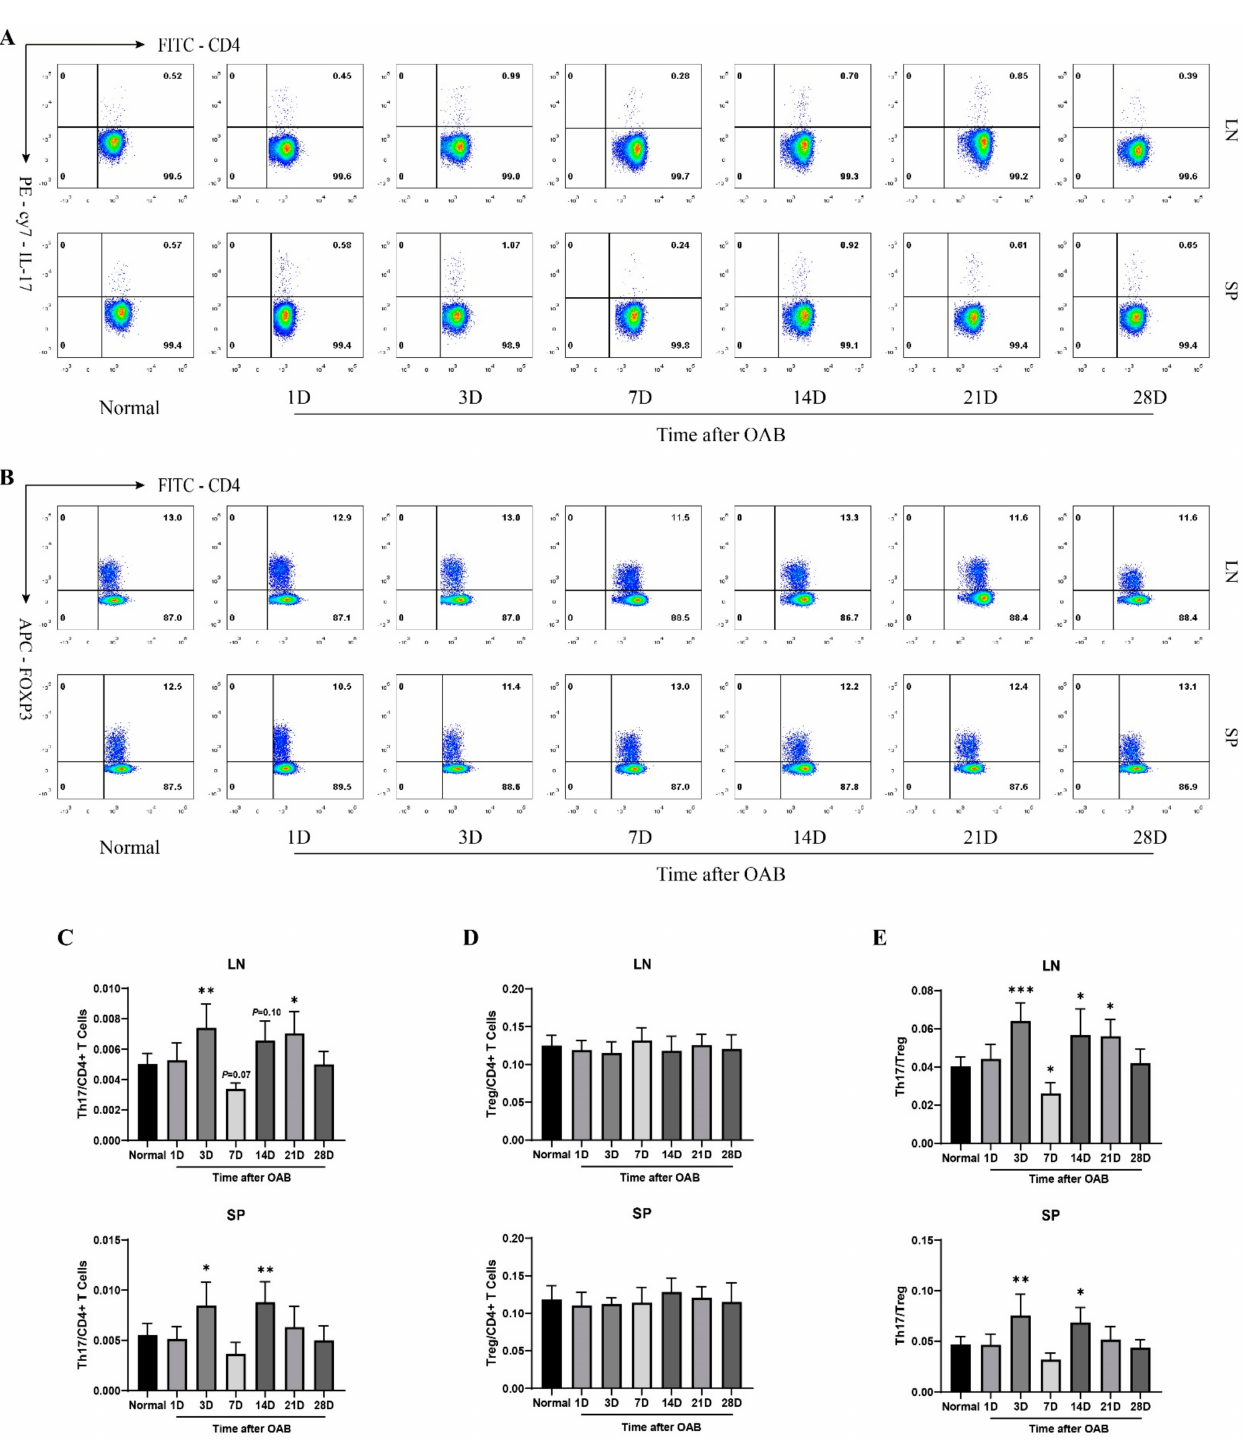
Figure 4. Dynamic changes in the frequencies of Th17 and Treg populations, and Th17/Treg ratio in lymph nodes and spleen after OAB. A and B: Flow cytometry analysis of Th17 ( A ) and Treg ( B ) cells in submaxillary and cervical lymph nodes (LN) and spleen (SP) of normal control and OAB-subjected eyes on the 1st, 3rd, 7th, 14th, 21st, and 28th day post-modeling. C, D, and E: Statistical analysis of the frequencies of Th17 ( C ), Treg ( D ), and Th17/Treg ratio ( E ) in LN and SP. Data are presented as mean ± SD ( n = 6, * p < 0.05, ** p < 0.01, *** p < 0.001 versus the control